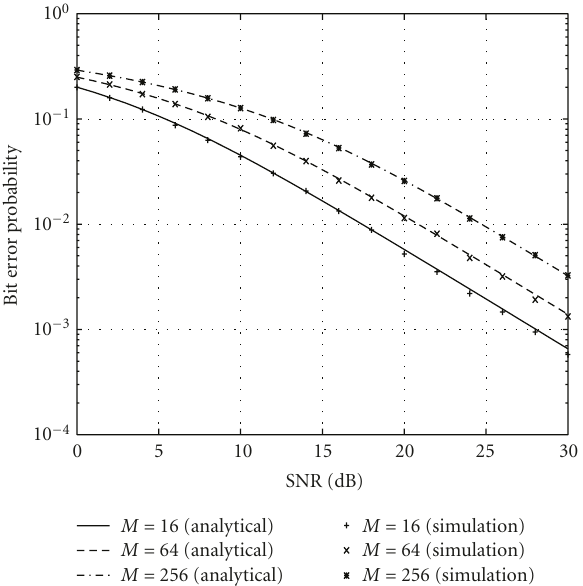
Figure 3: BEP for M -QAM subject to Nakagami- m fading for m = 0 . 95 and di ff erent values of M .